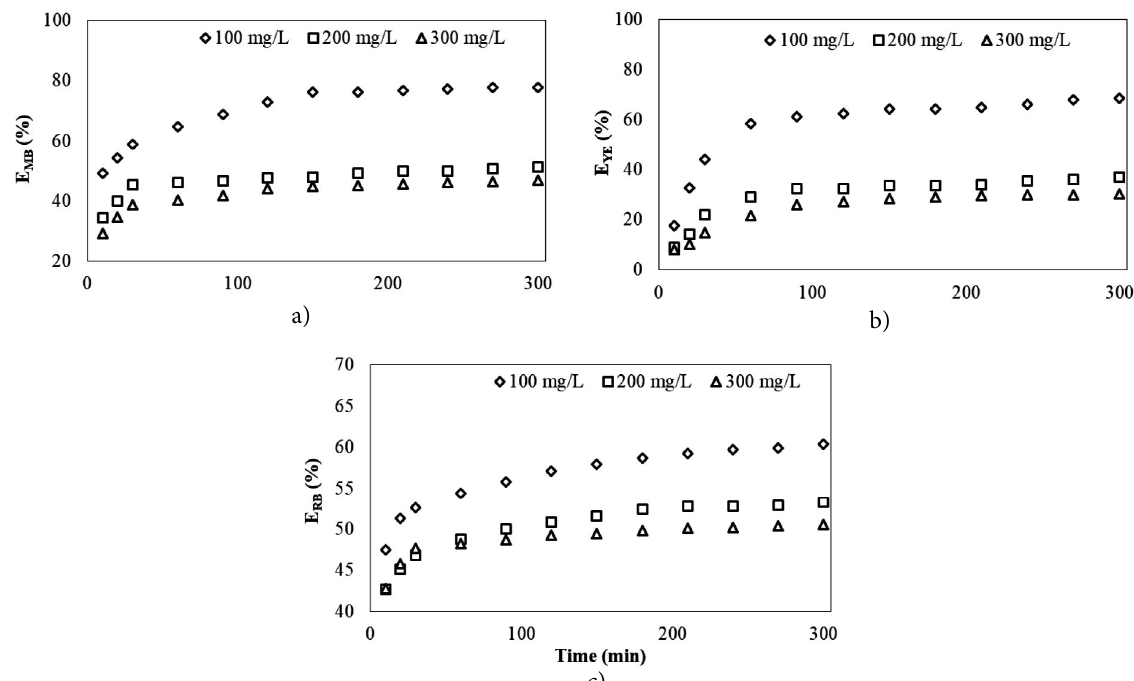
Fig. 3. Removal efficiency of MB (a), EY (b) and RB (c) adsorption on CNAC surface at different initial concentrations in time ( C o = 100–300 mg/L, m = 1.5 g, particle size = <0.5 mm, stirring rate = 75 rpm, V = 50 mL, time = 300 Table 1. Langmuir, Freundlich and Dubinin-Radushkevich isotherm parameters for dyes removal on CNAC surface. Isotherm model